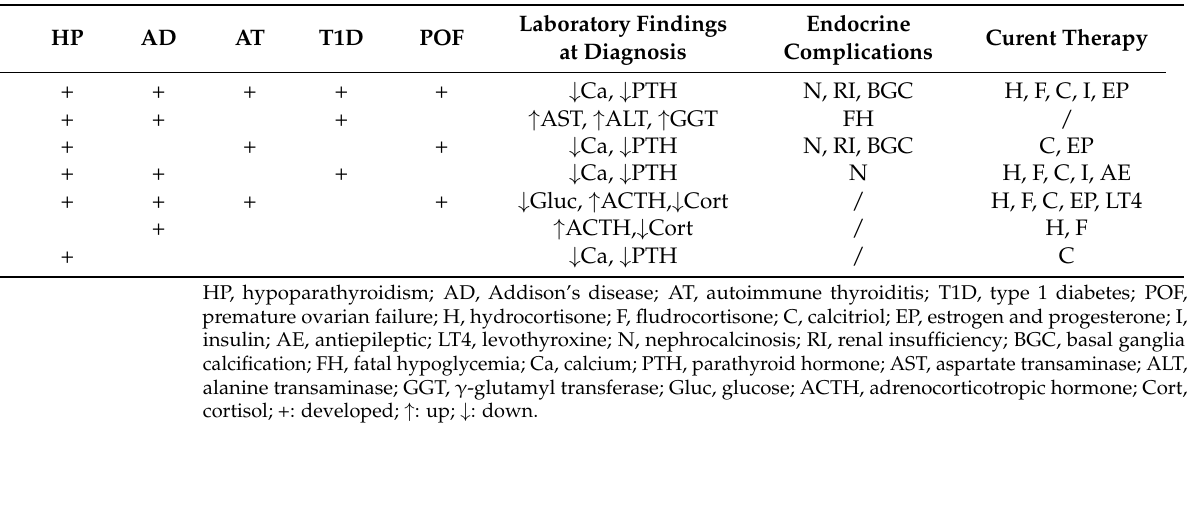
Table 1. Endocrinological manifestation and clinical features of the subjects enrolled in the